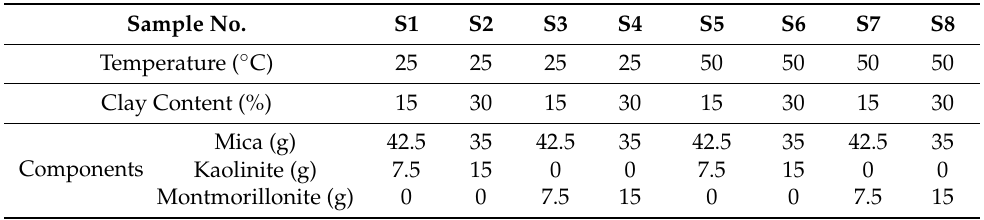
Composition of eight samples with different concentrations of mica, kaolinite and